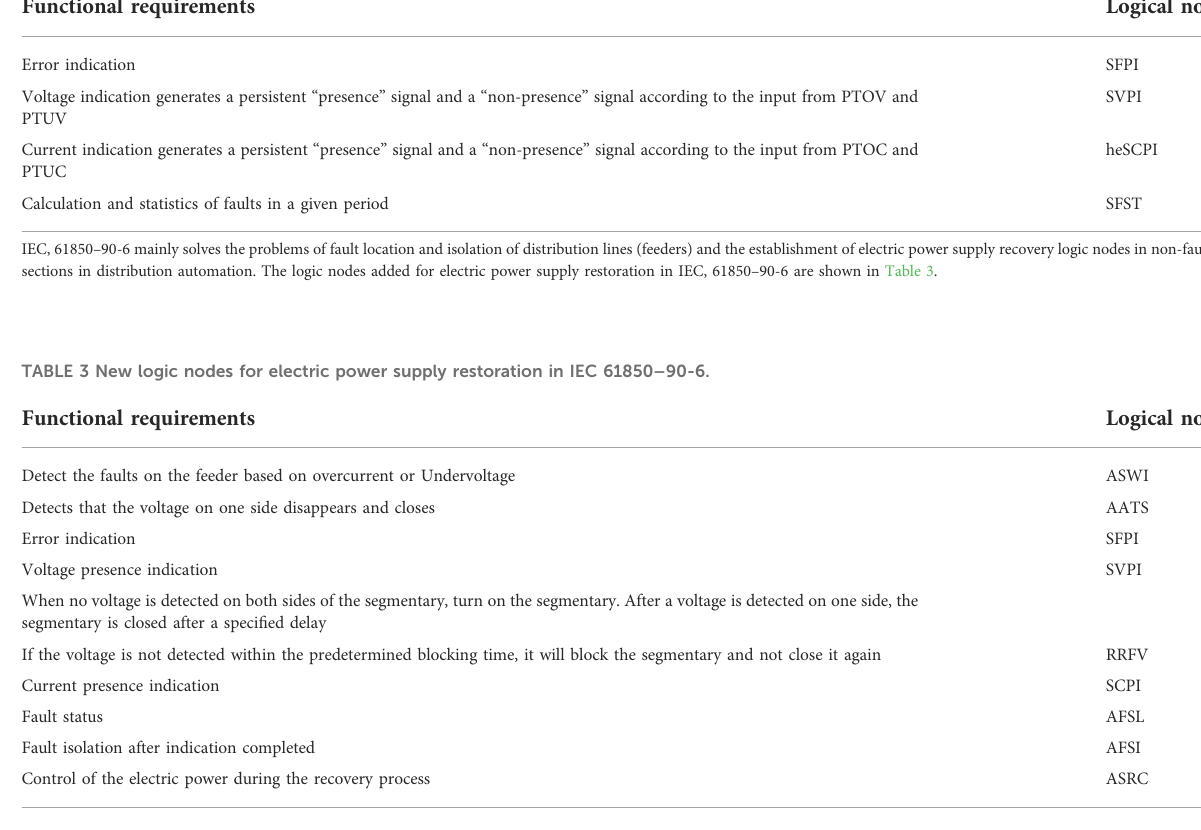
TABLE 2 New logical nodes for fault indication in IEC 61850 – 90-6.